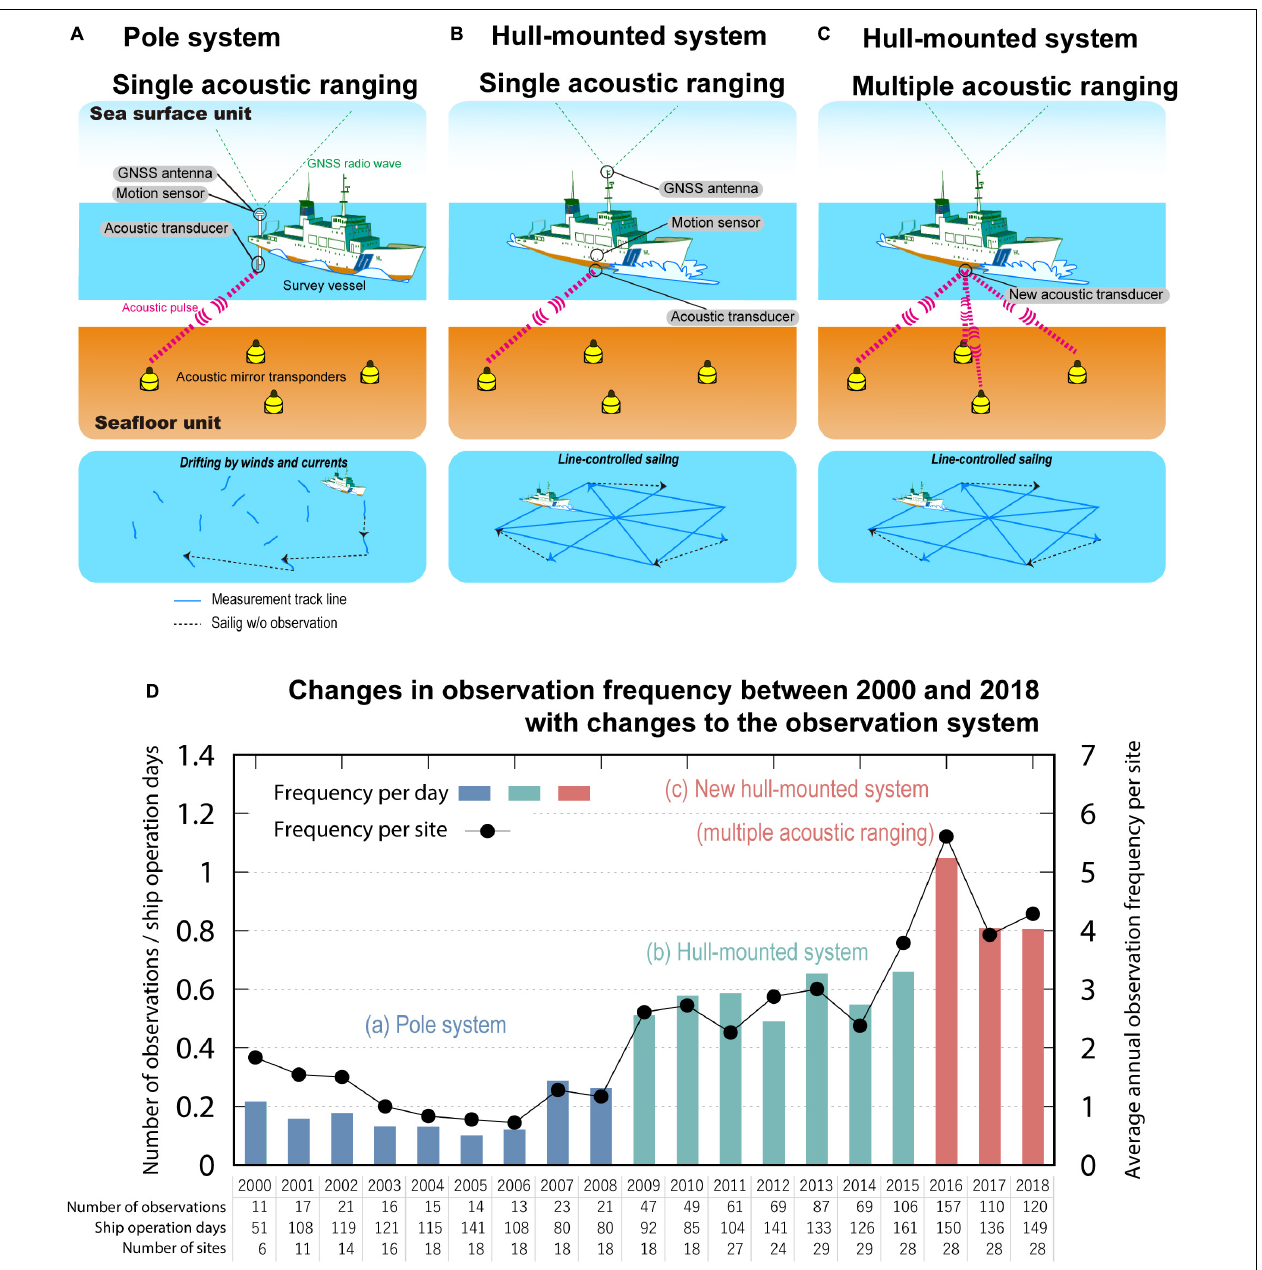
FIGURE 1 | History of the Japan Coast Guard’s Global Navigation Satellite System-Acoustic ranging combination technique (GNSS-A) observation system. (A) Schematic of the GNSS-A pole system. (B) Schematic of the GNSS-A hull-mounted system. (C) Schematic of the GNSS-A hull-mounted system with a new transducer for multiple acoustic ranging. (D) Changes in observation frequency between 2000 and 2018 with changes to the observation